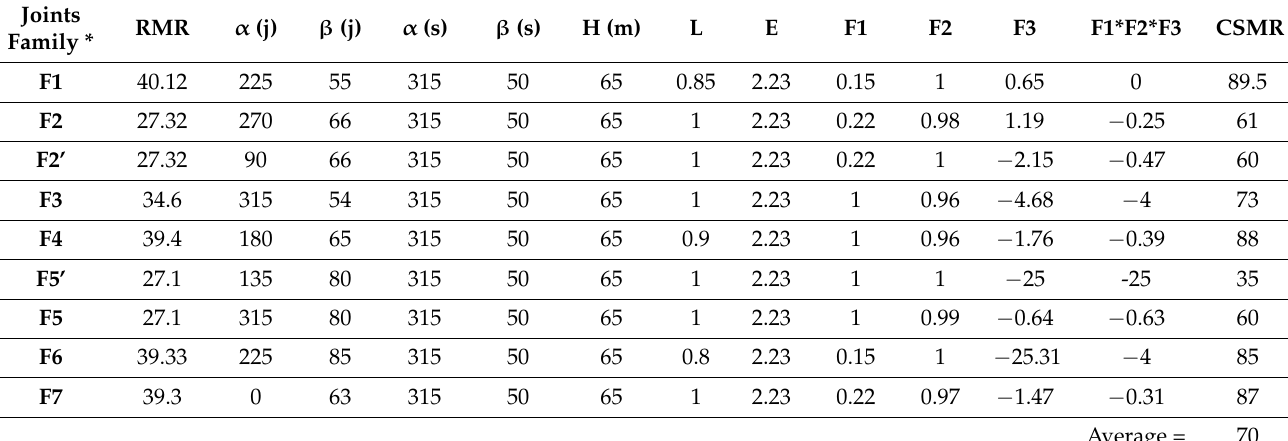
Table 1. CSMR analysis results for the Bouanane